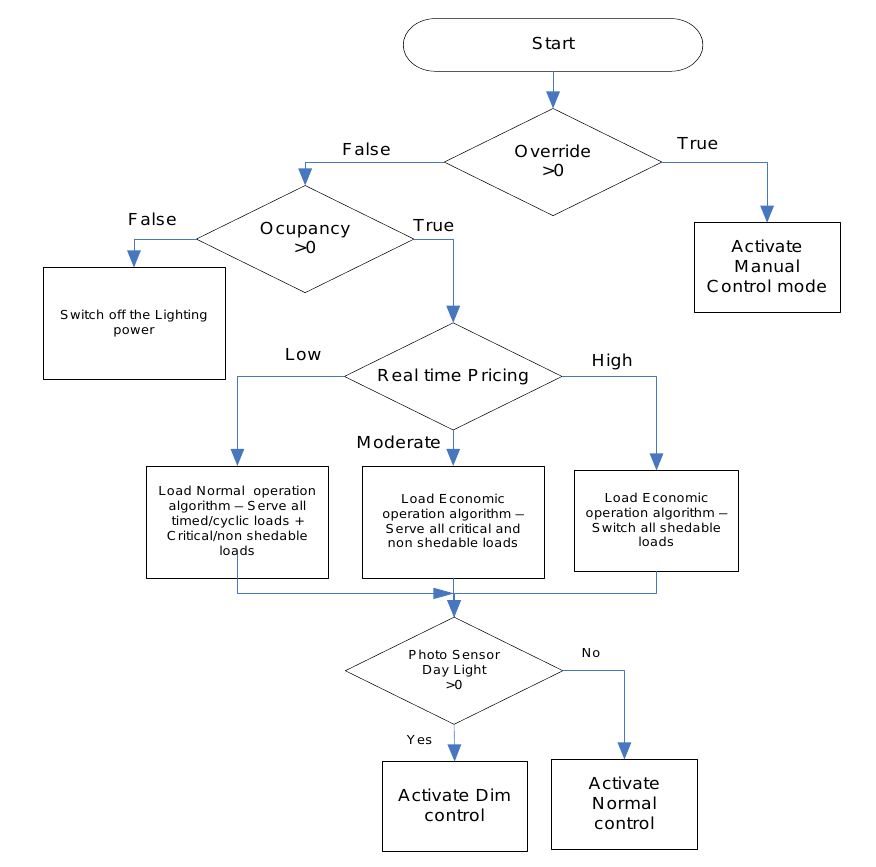
Figure 9. Lighting load control flow chart.